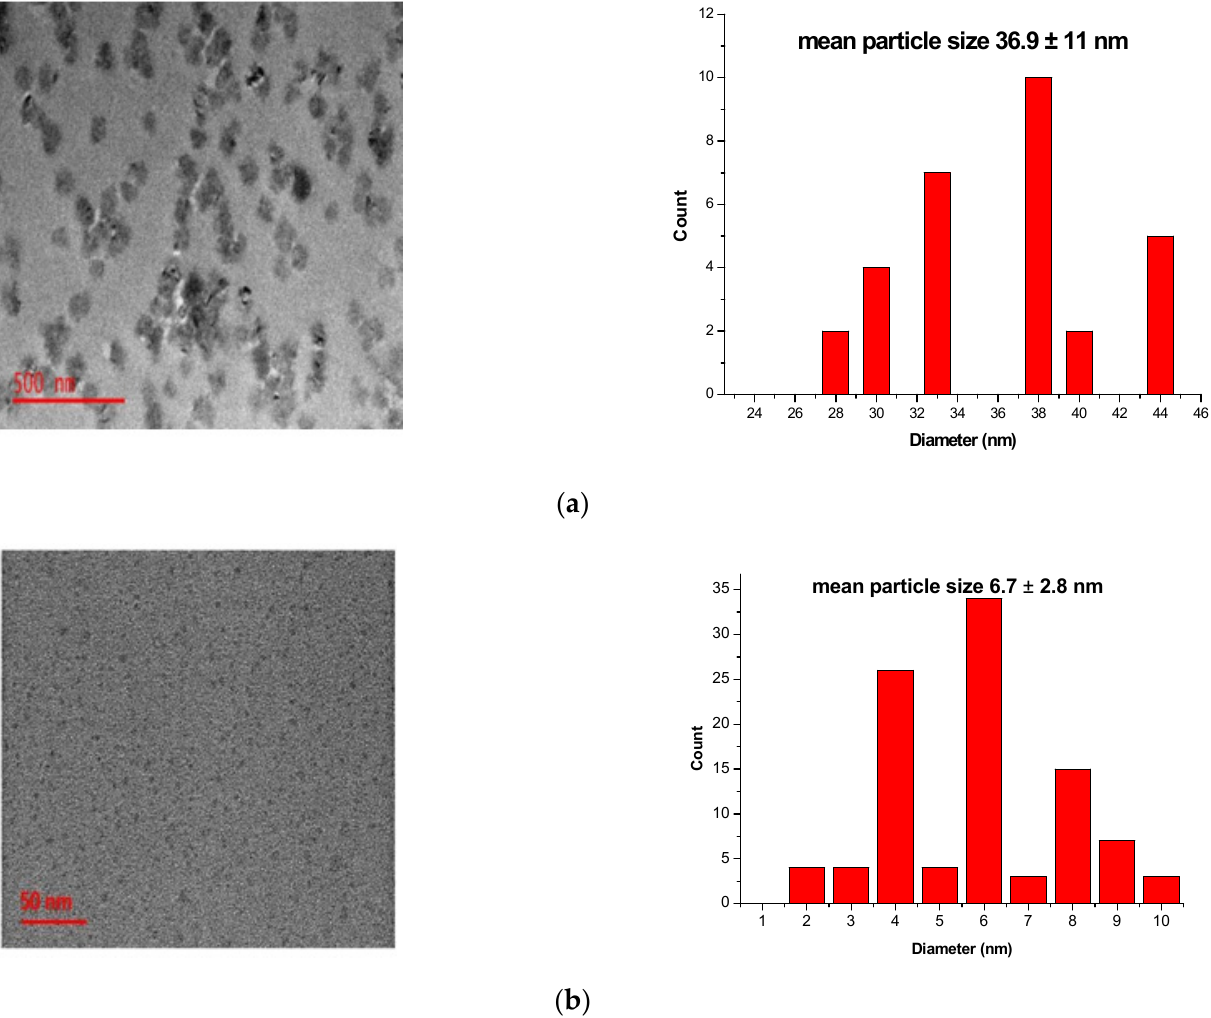
Figure 1. Characterization of the polyethersulfone (PES) and Carbon nanodots coated on polyethersulfone (CNDs/PES) using transmission electron microscopy (TEM). ( a ) before grinding; ( b ) after grinding.